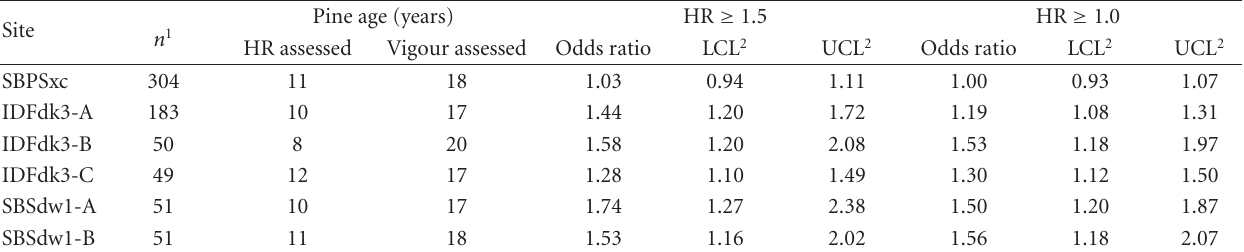
Table 4: Odds ratios and confidence limits associated with risk of lodgepole pine having unacceptable vigour as the density of neighbouring aspen with HR ≥ 1.5 and HR ≥ 1.0 increases by one